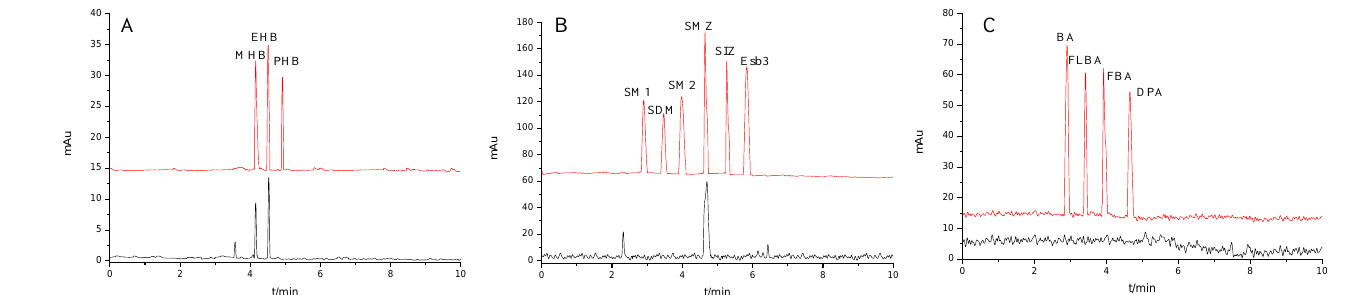
Figure 9. Separation chromatograms for actual samples: ( A ) hand cream (black line) and spiked with 20.0 mg/mL the mixture standard solution of the parabens (red line), ( B ) sulfamethoxazole tablets (black line) and spiked with 20.0 mg/mL the mixture standard solution of the sulfonamides (red line) and ( C ) drinking water (black line) and spiked with 20.0 mg/mL the mixture standard solution of the benzoic acids (red line). Experimental conditions: 20 mM of phosphate buffer (pH = 6); operating voltage, 15 kV; temperature, 20 °C. To evaluate the current method, it was compared with the previously reported ana- lytical methods [33, 38-47]. As shown in Table 7, the method in this work was found to be Table 7. Comparison of the data from this work with those from the relevant studies. very rapid (baseline separation of the analytes studied within 6 min), simple (only phos- phate buffer as separation media), sensitive and accurate (recovery rate 92.44–103.41%). Analysis Time Methods Analytes Furthermore, the method did not use the toxic organic solvents. Of course, the perfor- mance and mechanism of the TpBD COF immobilized capillary needs to be further stud- ied and explored to broaden its application field.